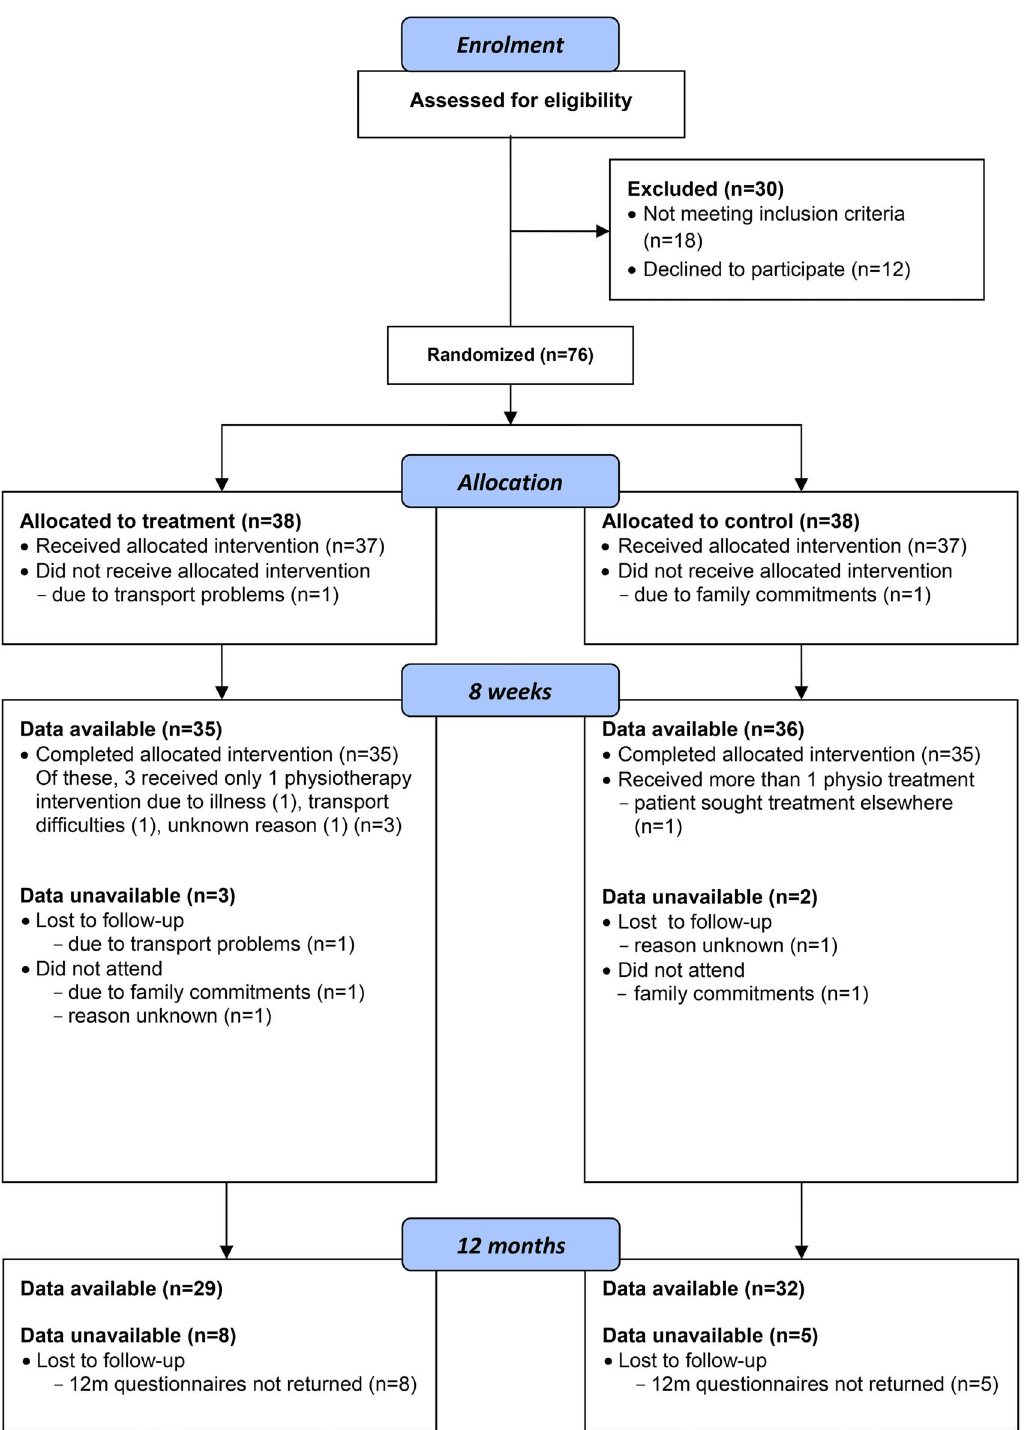
Figure 1. Flow chart of participants through trial.